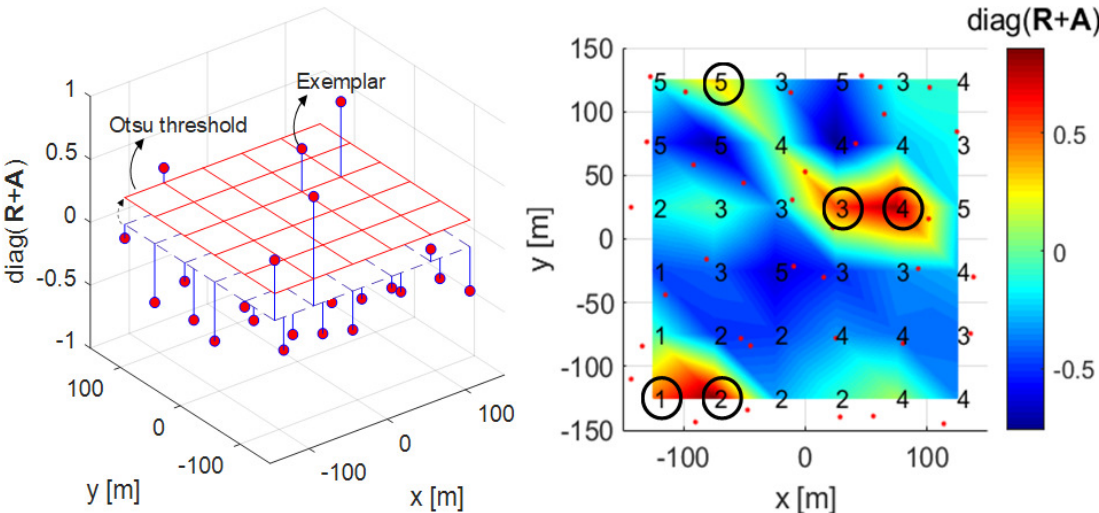
Figure 6. 3-D plot (left) and mesh plot (right) with Otsu threshold applied to the diagonal components of R + A in Algorithm